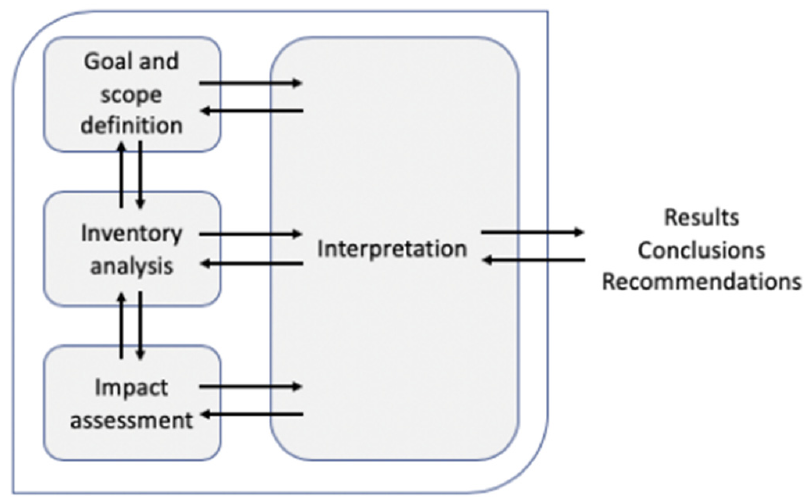
Figure 2. General methodological framework of LCA (Source: ISO 14040).